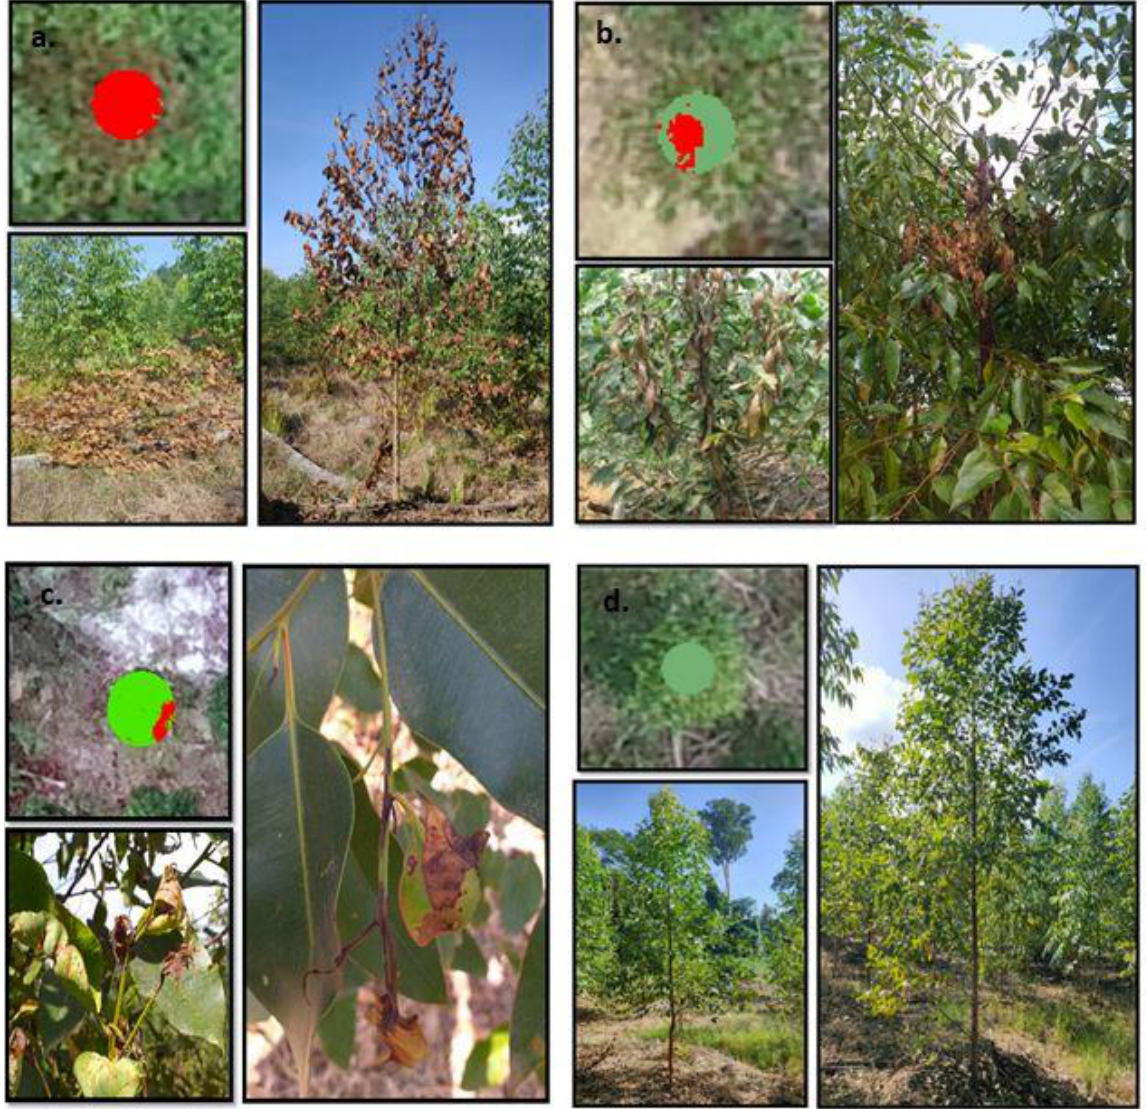
Figure 8. VARI-green and ground-truth images of ( a ) Class-1, dead; ( b ) Class-2, severe infection; ( c ) Class-3, mild infection; and ( d ) Class-4, healthy trees.